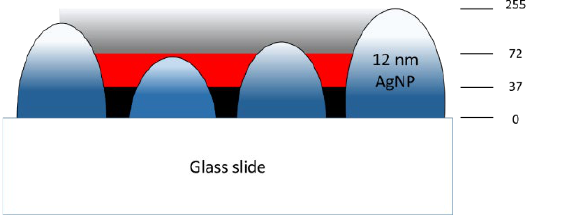
Figure 12. A schematic diagram of the hotspot region in the thickness direction on the Ag-deposited SERS substrate.